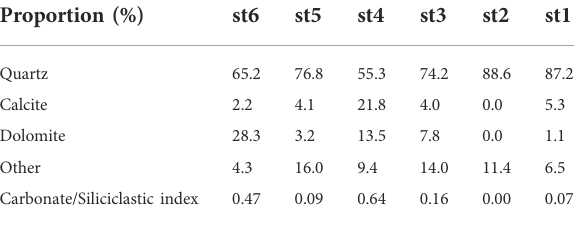
TABLE 4 Average proportion of each mineral and Carbonate/ Siliciclastic index displayed per station. Stations were ordered from West to